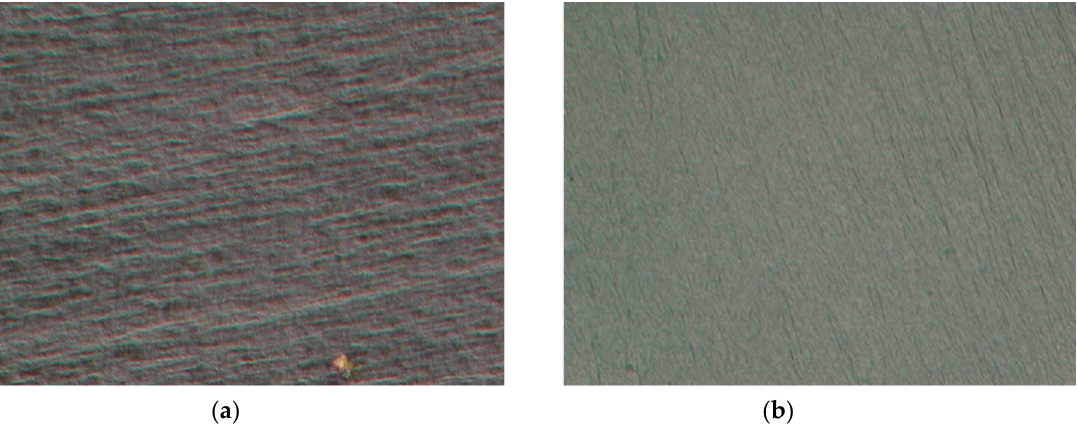
Figure 8. The fracture surfaces of neat DCPD with decelerator under CT ( − 160 °C) condition. (( a ) 1 wt.% decelerator, ( b ) 2 wt.% decelerator, up to 2000 × magnification).